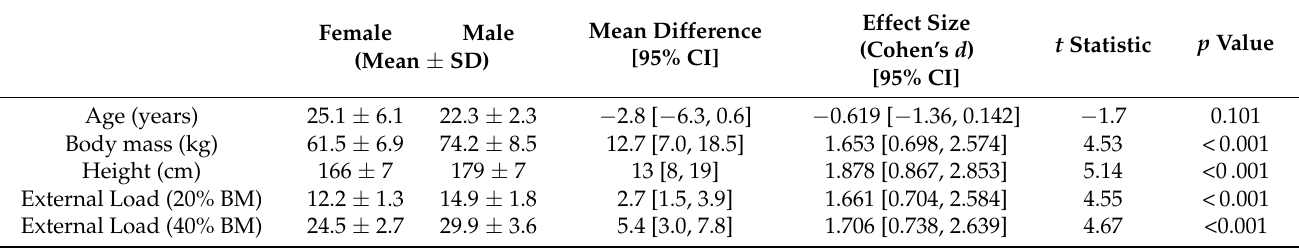
Table 1. Demographic and load differences between the female and male participants. BM: body